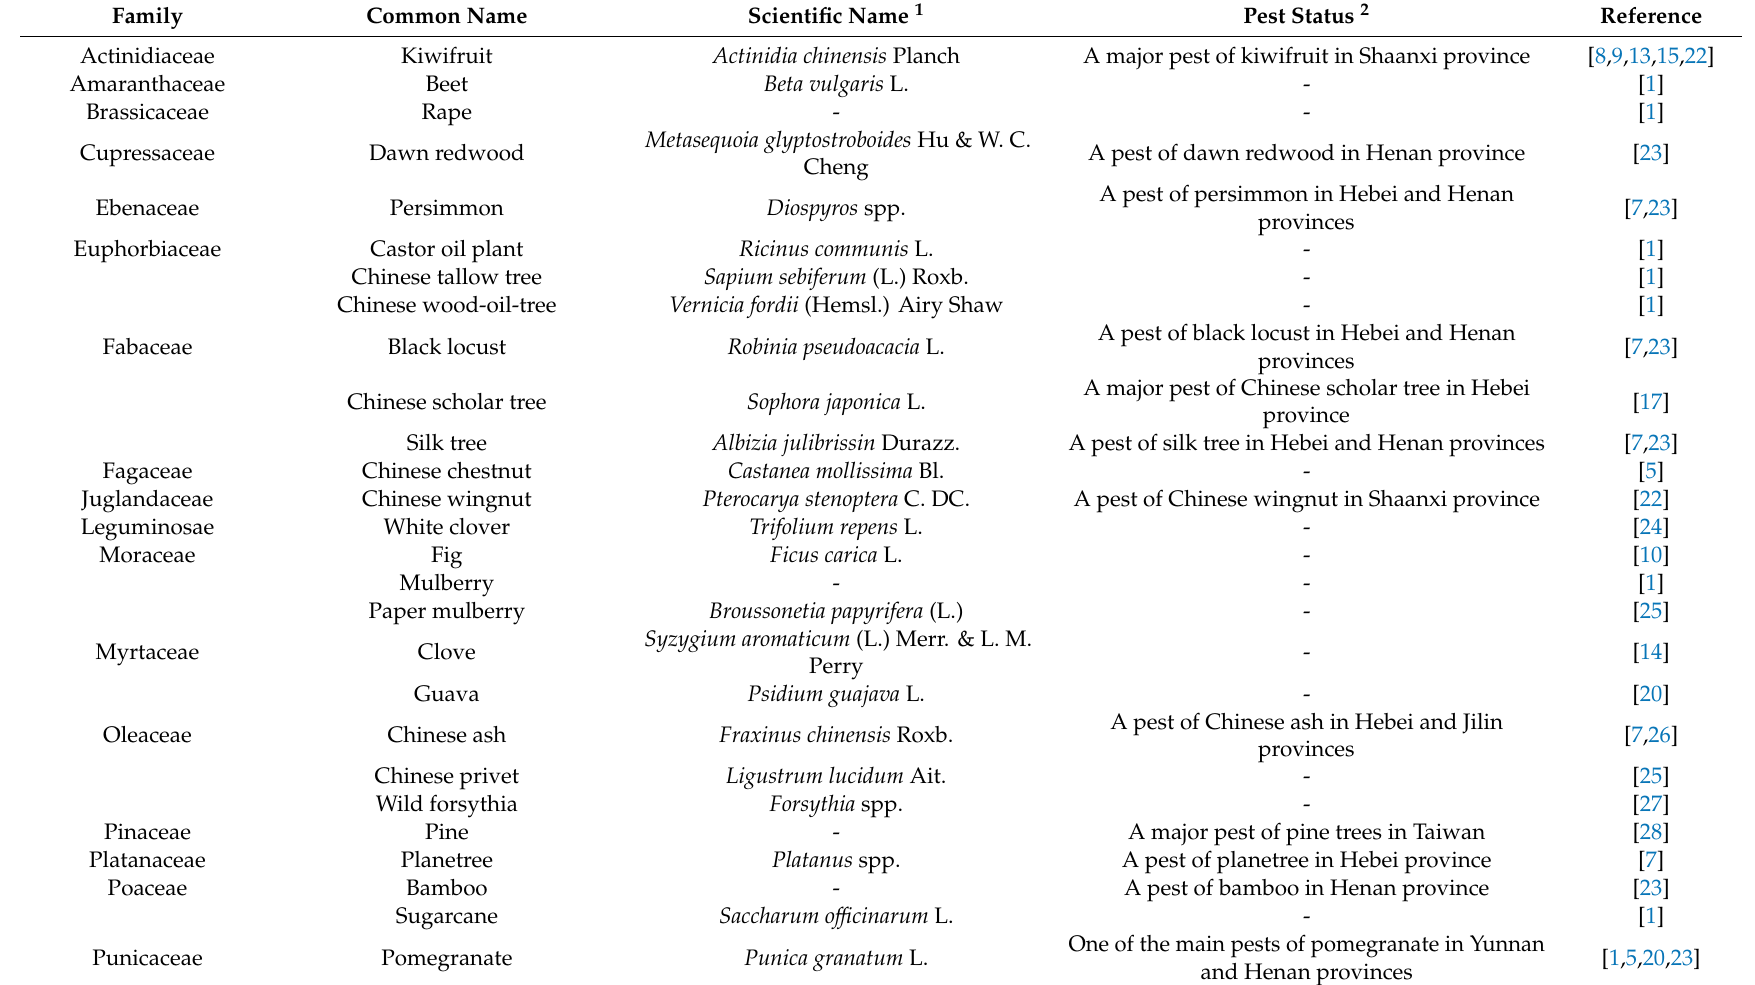
Table 2. Host plants and pest status of Erthesina fullo reported in